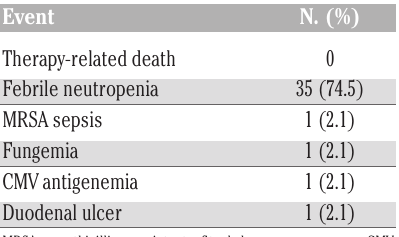
Table 2. Adverse events related to autolo- gous stem cell transplantation. Event